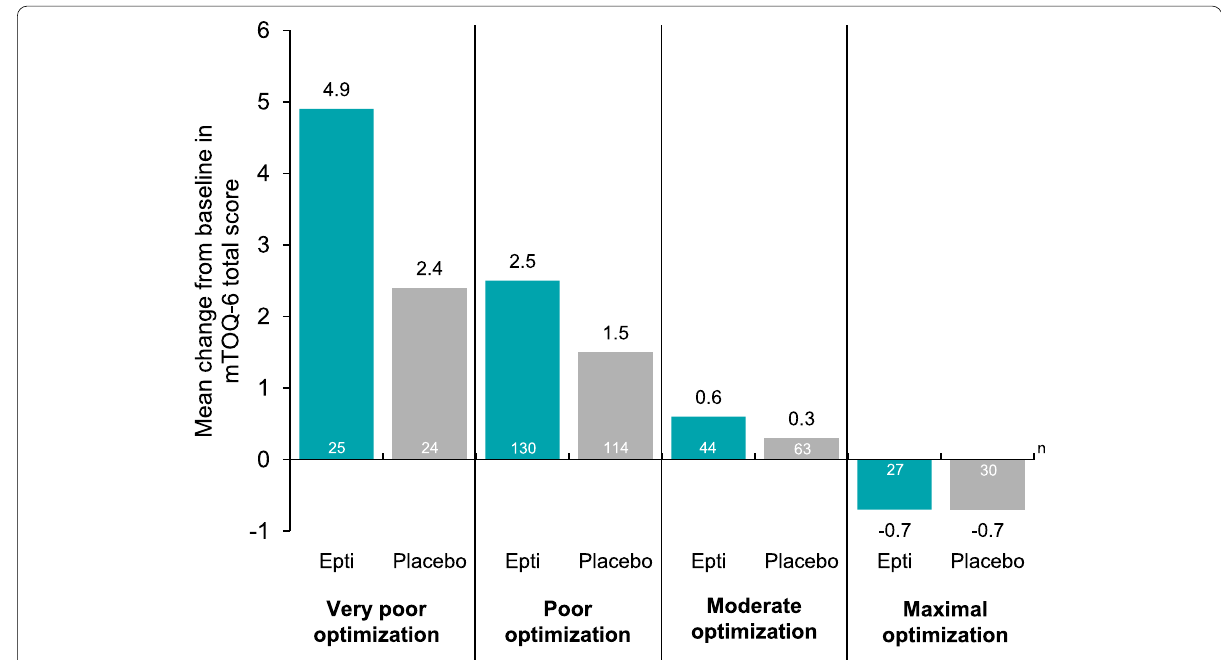
Fig. 3 Change from baseline to week 4 in mTOQ-6 total score by baseline acute treatment optimization subgroup. Patients were grouped by baseline mTOQ-4 total scores into the following optimization categories: very poor (0), poor (1–5), moderate (6–7), and maximal (8). The mTOQ-6 total score ranges from 6 to 24, with higher scores indicating better acute medication optimization. Epti, eptinezumab (100 mg); mTOQ-4/mTOQ-6, 4-item/6-item Migraine Treatment Optimization Questionnaire